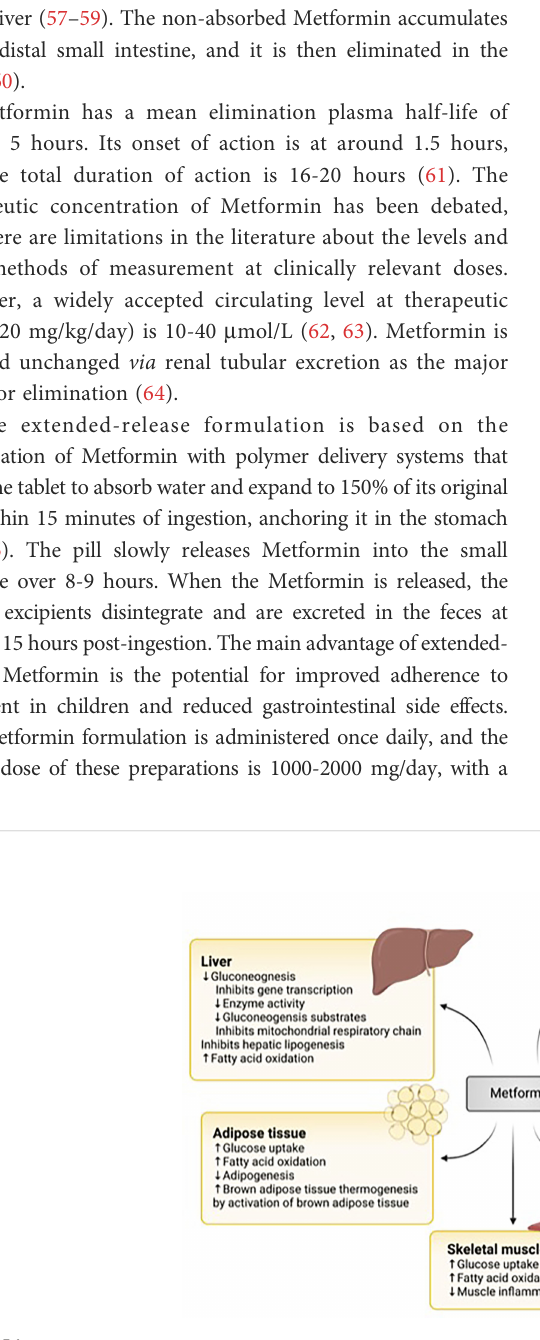
FIGURE 1 The mechanisms of action of metformin. In the liver, metformin downregulates gluconeogenesis by inhibiting gene transcription, gluconeogenic enzyme activity and substrates, and the mitochondrial respiratory chain. It also inhibits lipogenesis and upregulates fatty acid oxidation. In the adipose tissue, it increases glucose uptake and fatty acid oxidation and brown adipose tissue while downregulating adipogenesis. In skeletal muscle, metformin stimulates glucose uptake and fatty acid oxidation. Metformin inhibits the nuclear factor KB (NFKB) pathway in immune cells and the differentiation of monocytes to macrophages. It also lowers in fl ammatory cytokine production and the neutrophil to lymphocyte chain. In the gastrointestinal tract, it modulates the gut microbiome, decreases glucose absorption from the intestin, It also increases glucose transport from the blood to the gut lumen, glucose utilization by intestinal cells, and glucagon peptide-1 (GLP-1) secretion. Figure created with